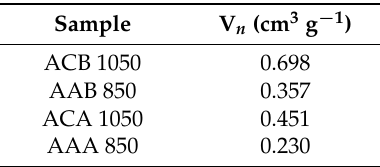
Figure 2. Size distribution of ultramicropores determined by physisorption of CO 2 at 0 °C using the NLDFT theoretical method in materials: ( A ) ACA 1050; ( B ) AAB 850; ( C ) ACA 1050; and ( D ) AAA 850. Table 2. Volume of the ultramicropores determined by the Dubinin-Radushkevich model used with CO 2 isotherms taken at 0 °C.